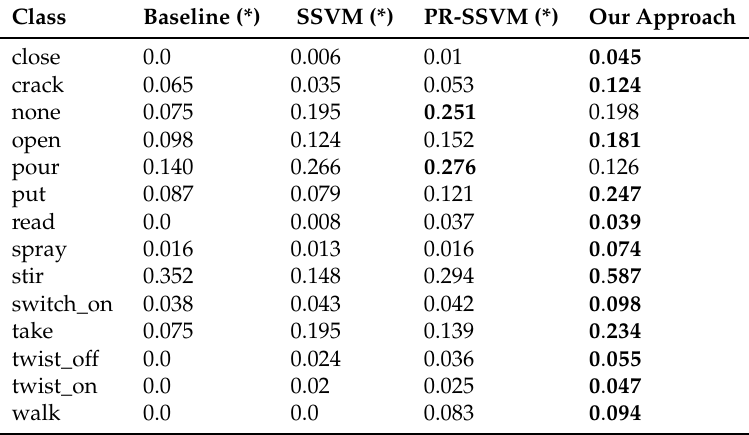
Table 6. Comparison against state-of-the-art approach. Values marked with a (*) are directly taken from [42]. Here the model is learned on 8 subject and tested on the remaining